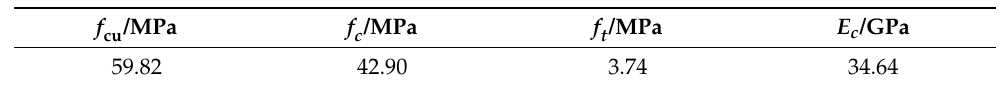
Figure 2. Concrete material test. Table 1. C50 Properties of Concrete